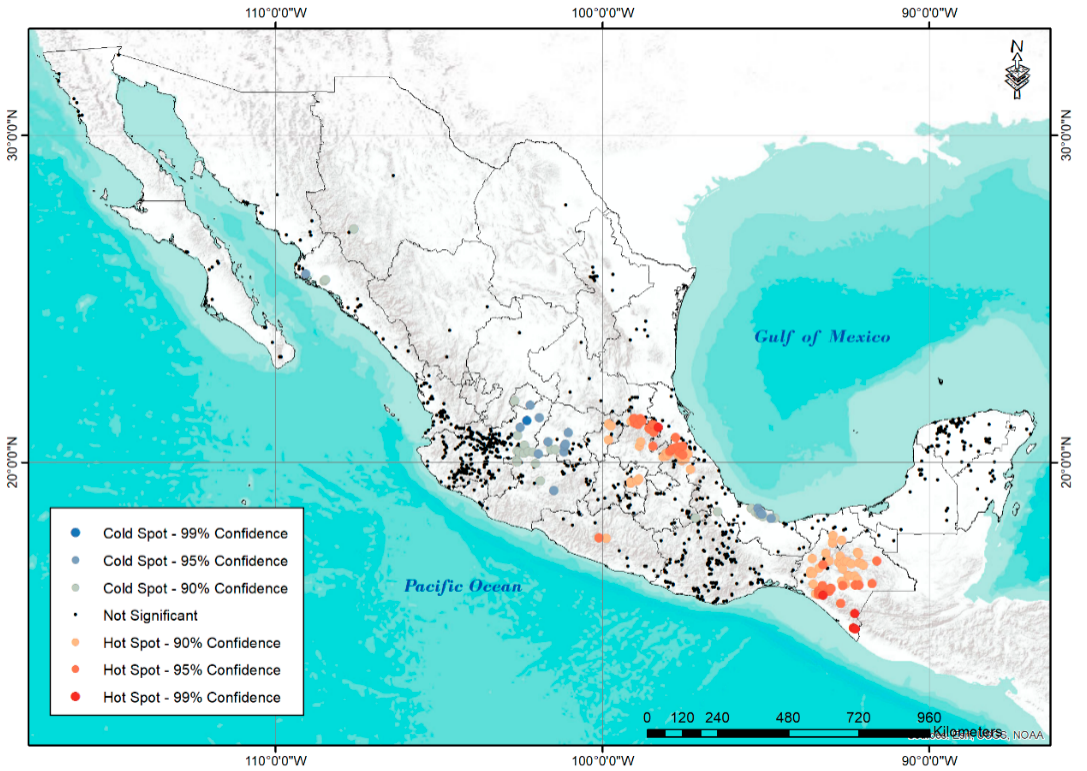
Figure 5. Abundance map of hotspot (red) and coldspot (blue) for 1296 S. lycopersicum L. accessions in Mexico.